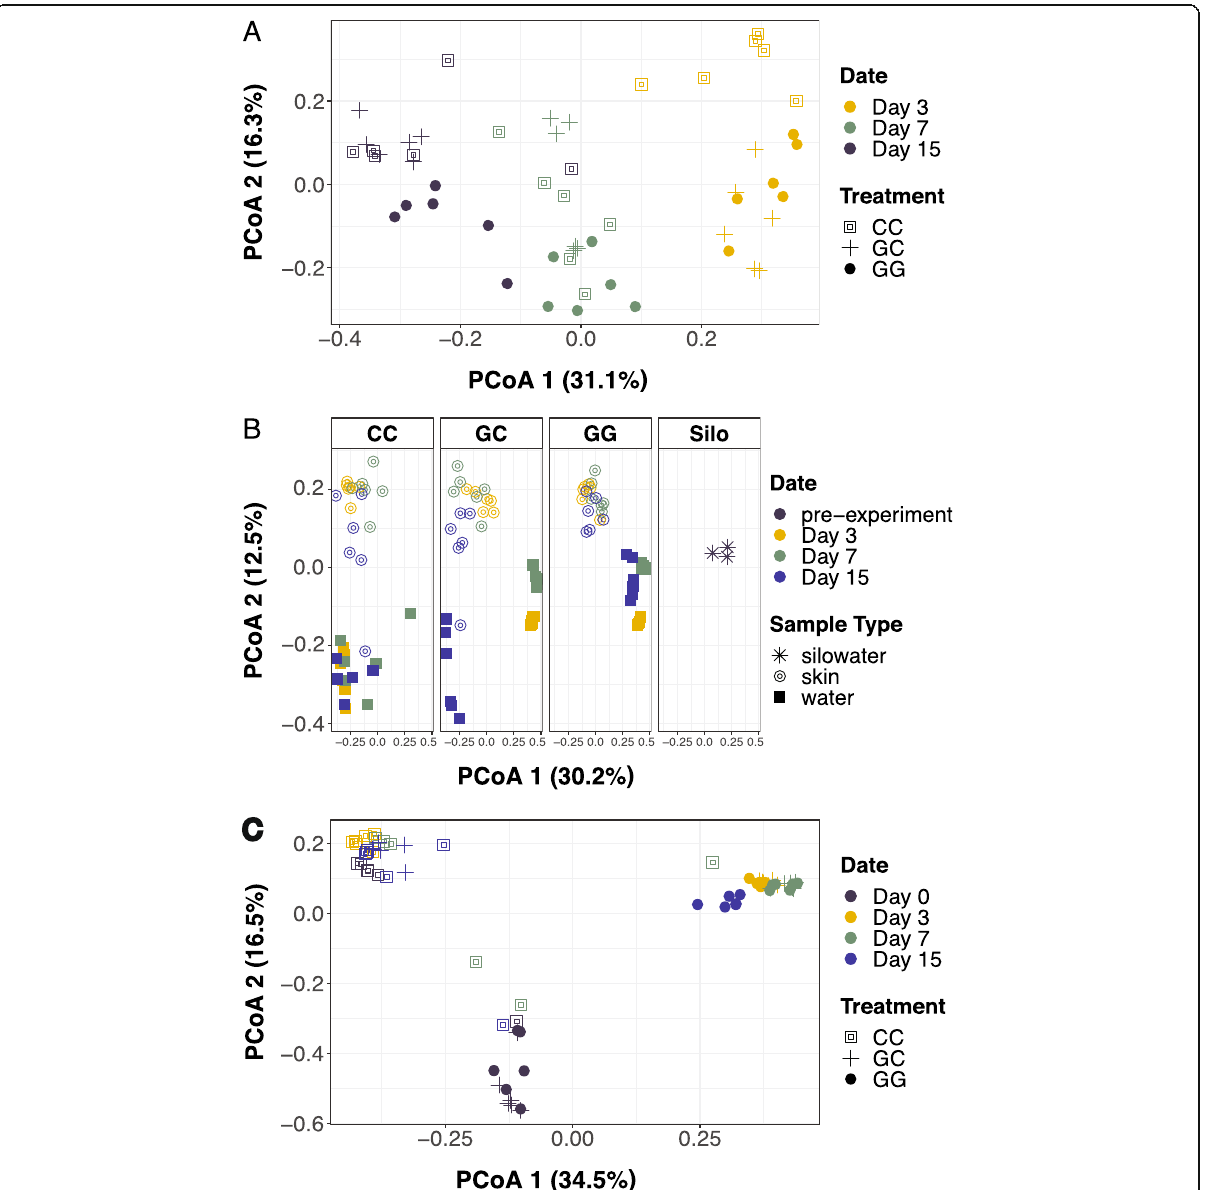
Fig. 1 a Principle coordinates analysis (PCoA) ordination of Bray-Curtis distances between microbial communities on larval sablefish skin over time. b Bray-Curtis PCoA of microbial communities associated with larval skin, hatching silo water, and experimental tank water. c Bray-Curtis PCoA of tankwater microbial communities over time. Silo water was only sampled once prior to the experiment/stock-out (pre-experiment). Each point represents a single sample ( n = 6 per treatment for each date and sample type. Pre-experiment silo water n = 3). CC = claywater for 15 days. GC = greenwater with a switch to claywater after 1 week. GG = greenwater for 15